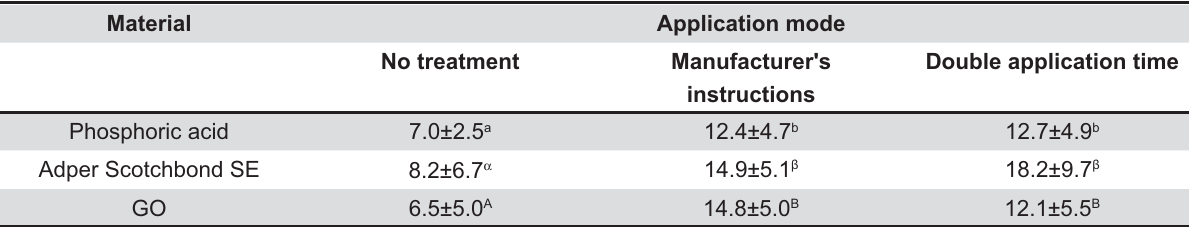
Table 3- Relative percentage of the tubule area opening (means ± standard deviations) obtained for each experimental condition (*)